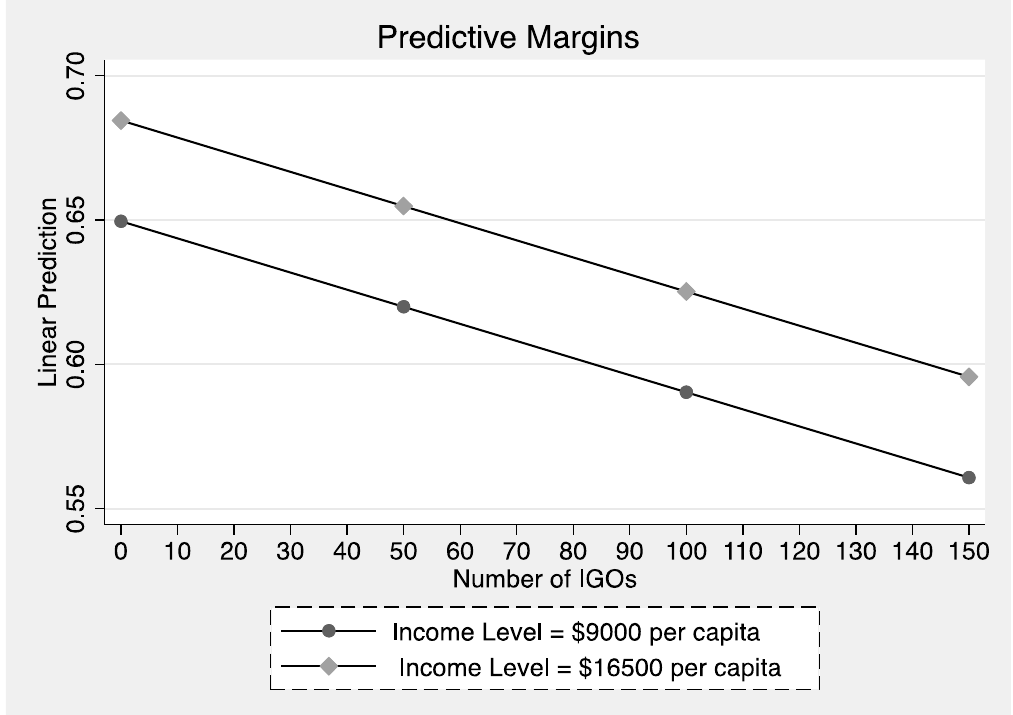
Figure 1. Fitted values of the quality of government index and democracy. Note: The dependent variable, The quality of government index, ranges from ZERO to ONE. Higher scores indicate better government performance. In our sample, the mean of the quality of government index is 0.56; SD = 0.23. The mean number of IGOs in which a country participated during the time period of our analysis is 49 (SD = 23.6).